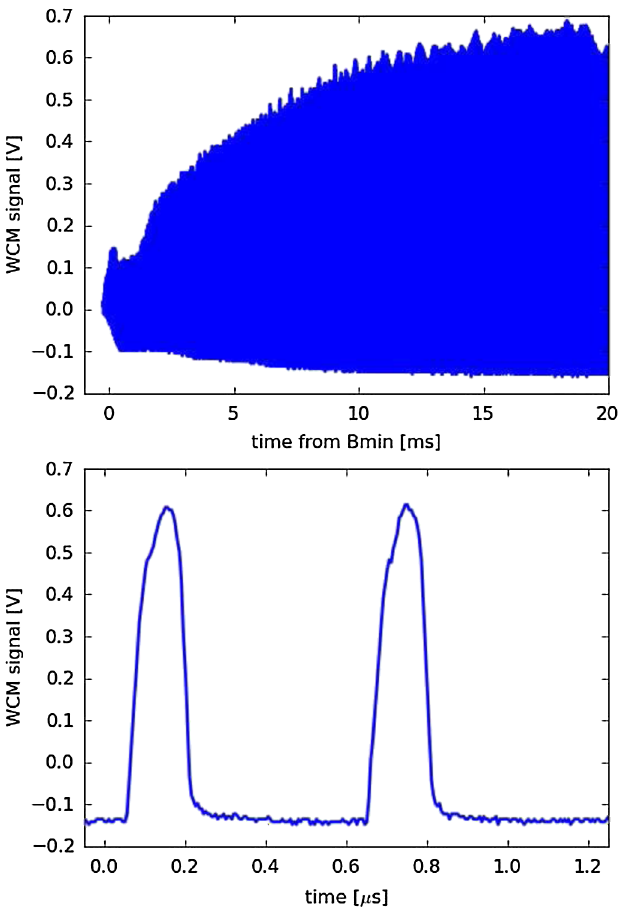
FIG. 6. The gap voltage monitor signal of cavity #10 (chan- nel 3). The envelope of full waveform from the injection to the extraction (upper) and a magnified view near the extraction (lower). The gap voltage consists of only the wake